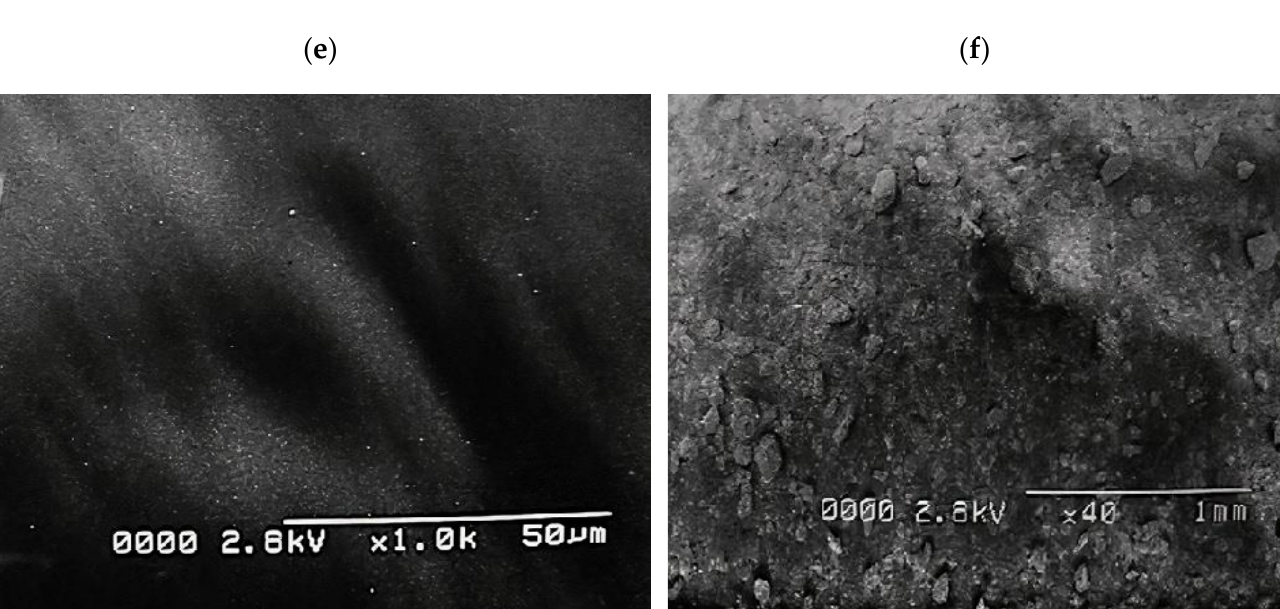
Figure 1. ( a ) CdS, ( b ) MoS 2 , ( c ) CdS/MoS 2 /Bi 2 S 3 composites (1%/1%/1%), ( d ) CdS/MoS 2 /Bi 2 S 3 composites (1%/5%/5%), ( e ) CdS/MoS 2 /Bi 2 S 3 Composites (2%/5%/5%), and ( f ) CdS/MoS 2 /Bi 2 S 3 composites (0.1%/1%/1%).